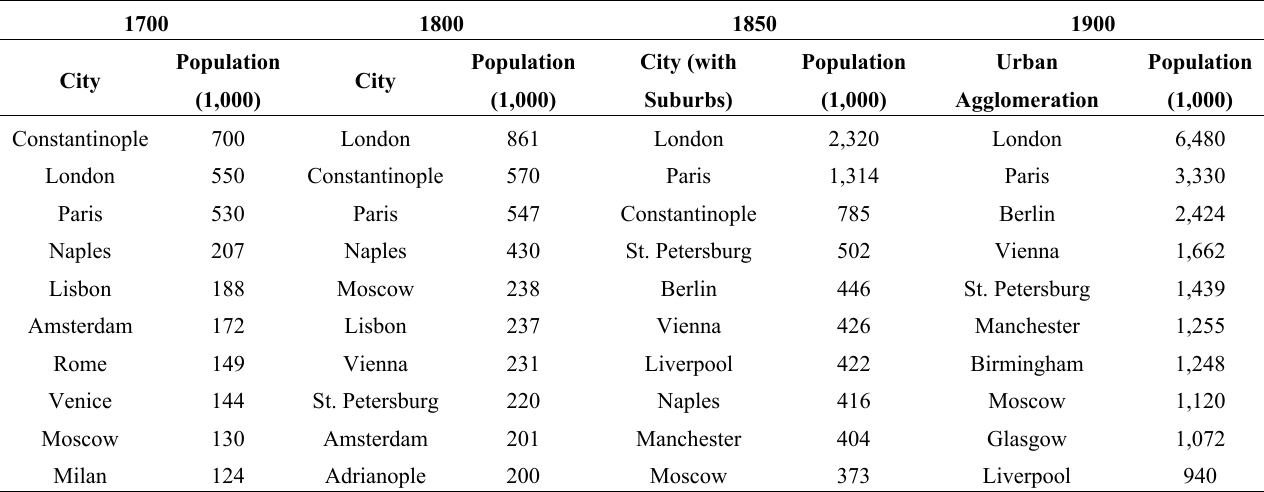
Table 1. Numbers of population of the 10 biggest European cities, in the years 1700, 1800, 1850 and 1900